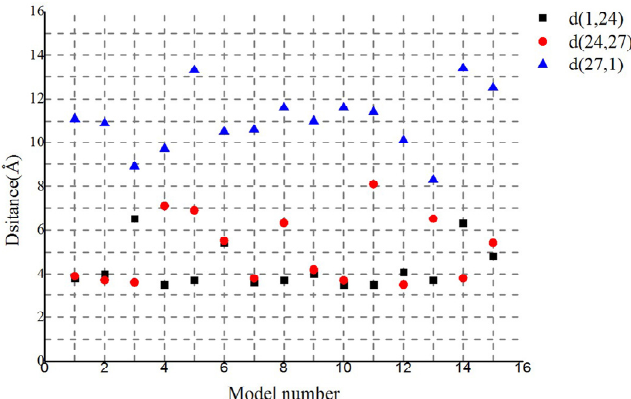
Figure 6. Distances between proximal carbon atoms in neighboring aromatic rings for the 15 lowest energy structures in the largest cluster. As shown in legends, different color points indicate distances between different residues.